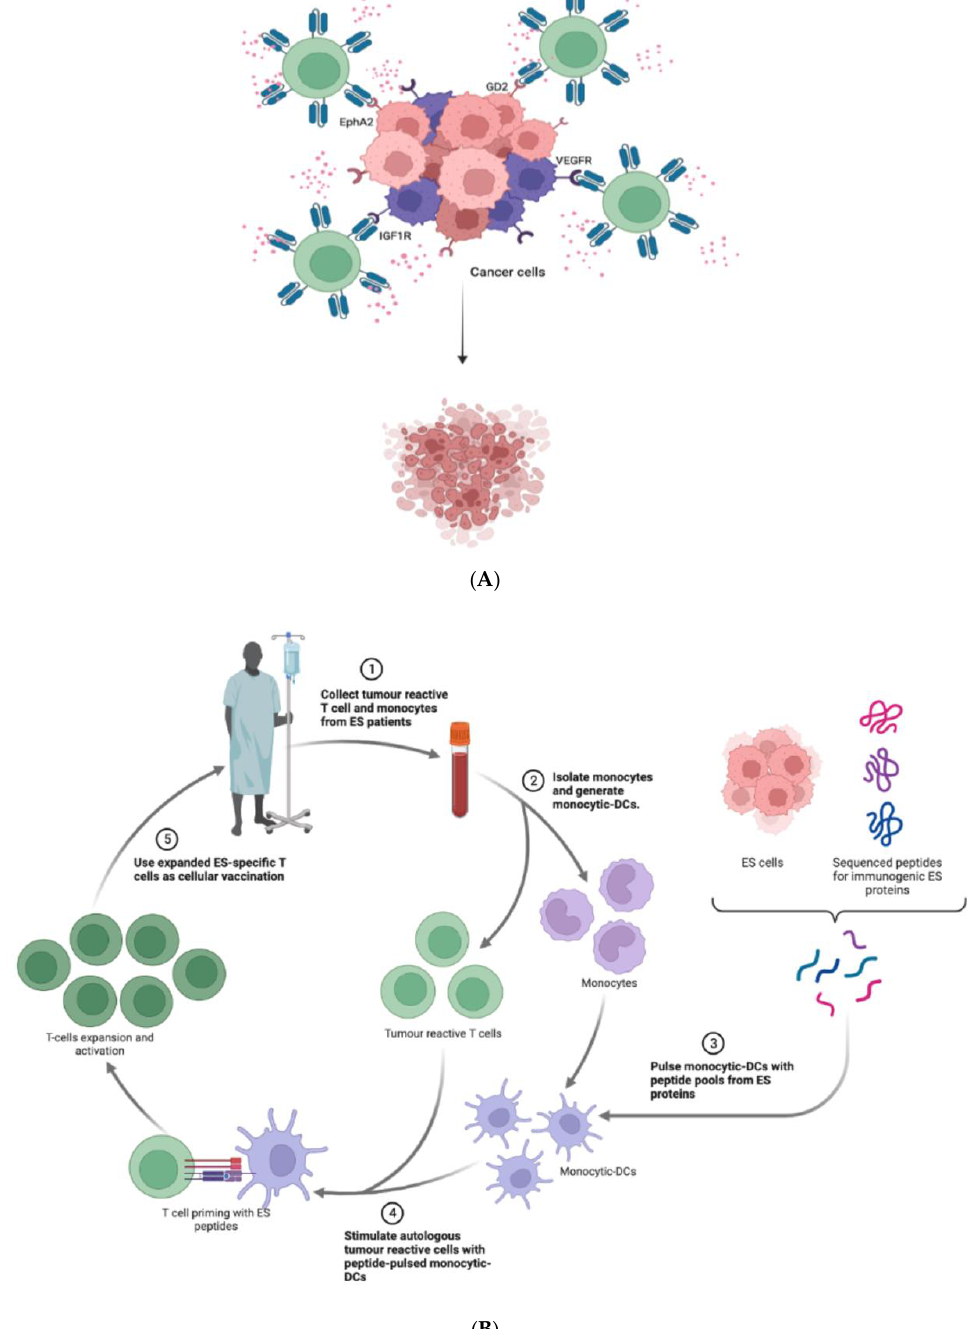
Figure 4. ( A ) e ( B ) Immunotherapy in ES. (Created with